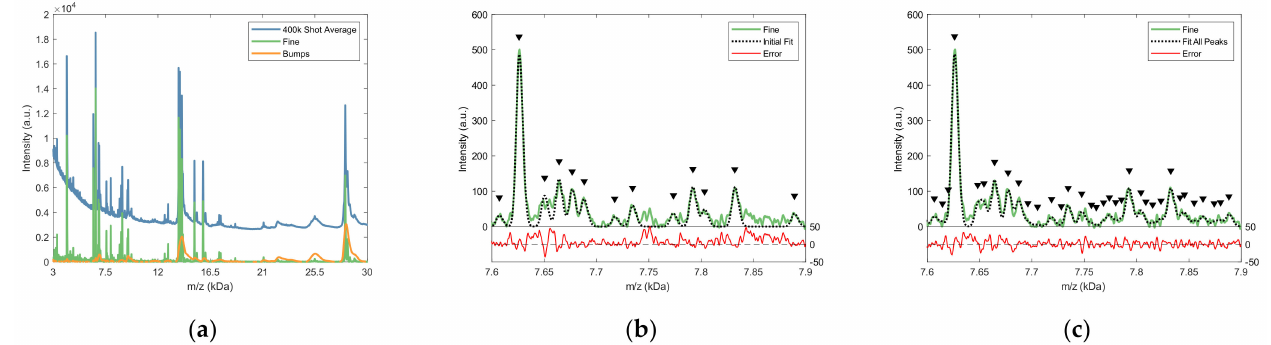
Figure 5. Visual representation of peak fitting and feature value determination. ( a ) A single-processed Deep MALDI spectrum showing the fine structure (green) and bumps (yellow) components. ( b ) Initial peak finding and result of applying the fitting algorithm to the fine structure of a single spectrum in the range 7.5–7.9 kDa. ( c ) The complete fitting of the same range using the master list of all peaks. The triangles indicate locations of fitted peaks and the red trace at the bottom shows the error in the peak